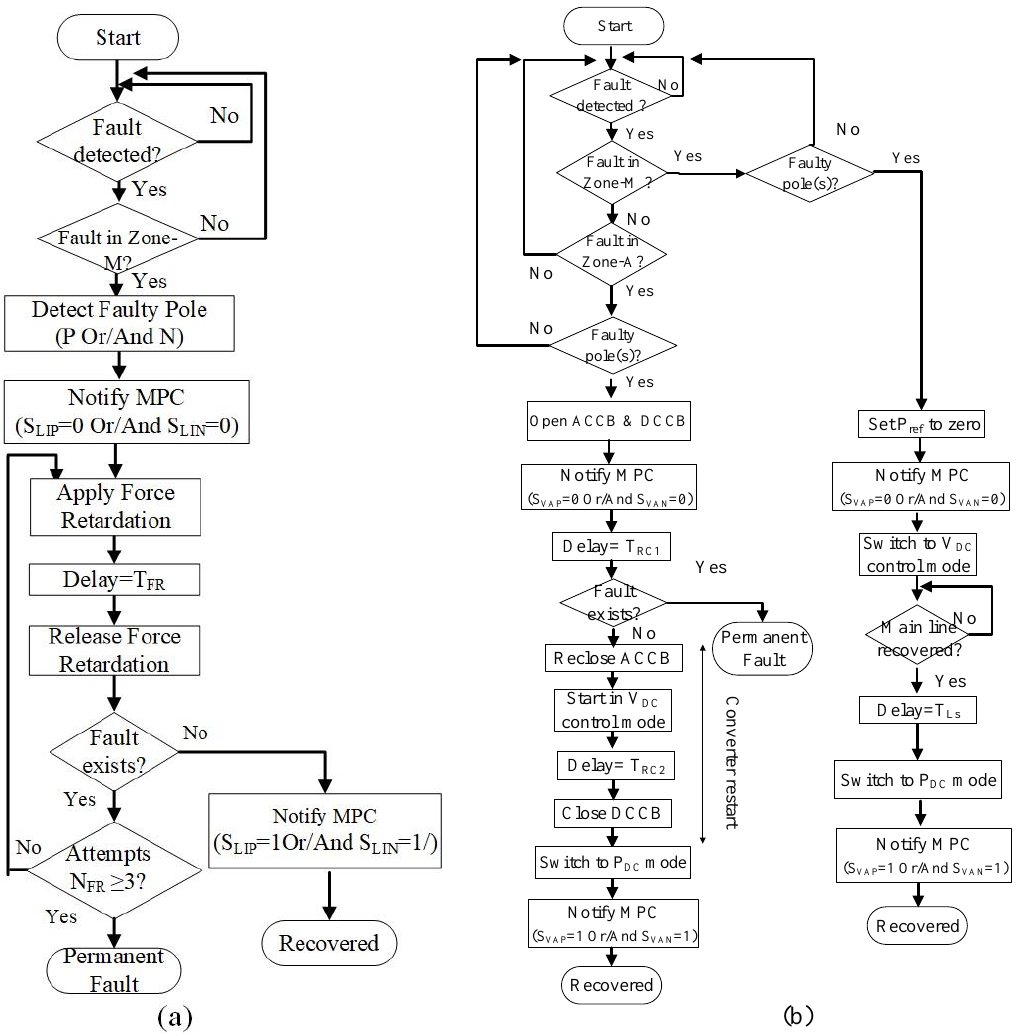
Figure 4. The fault recovery process, ( a ) at LCC rectifier station, ( b ) at VSC-A station (the same procedure is used at VSC-B station).